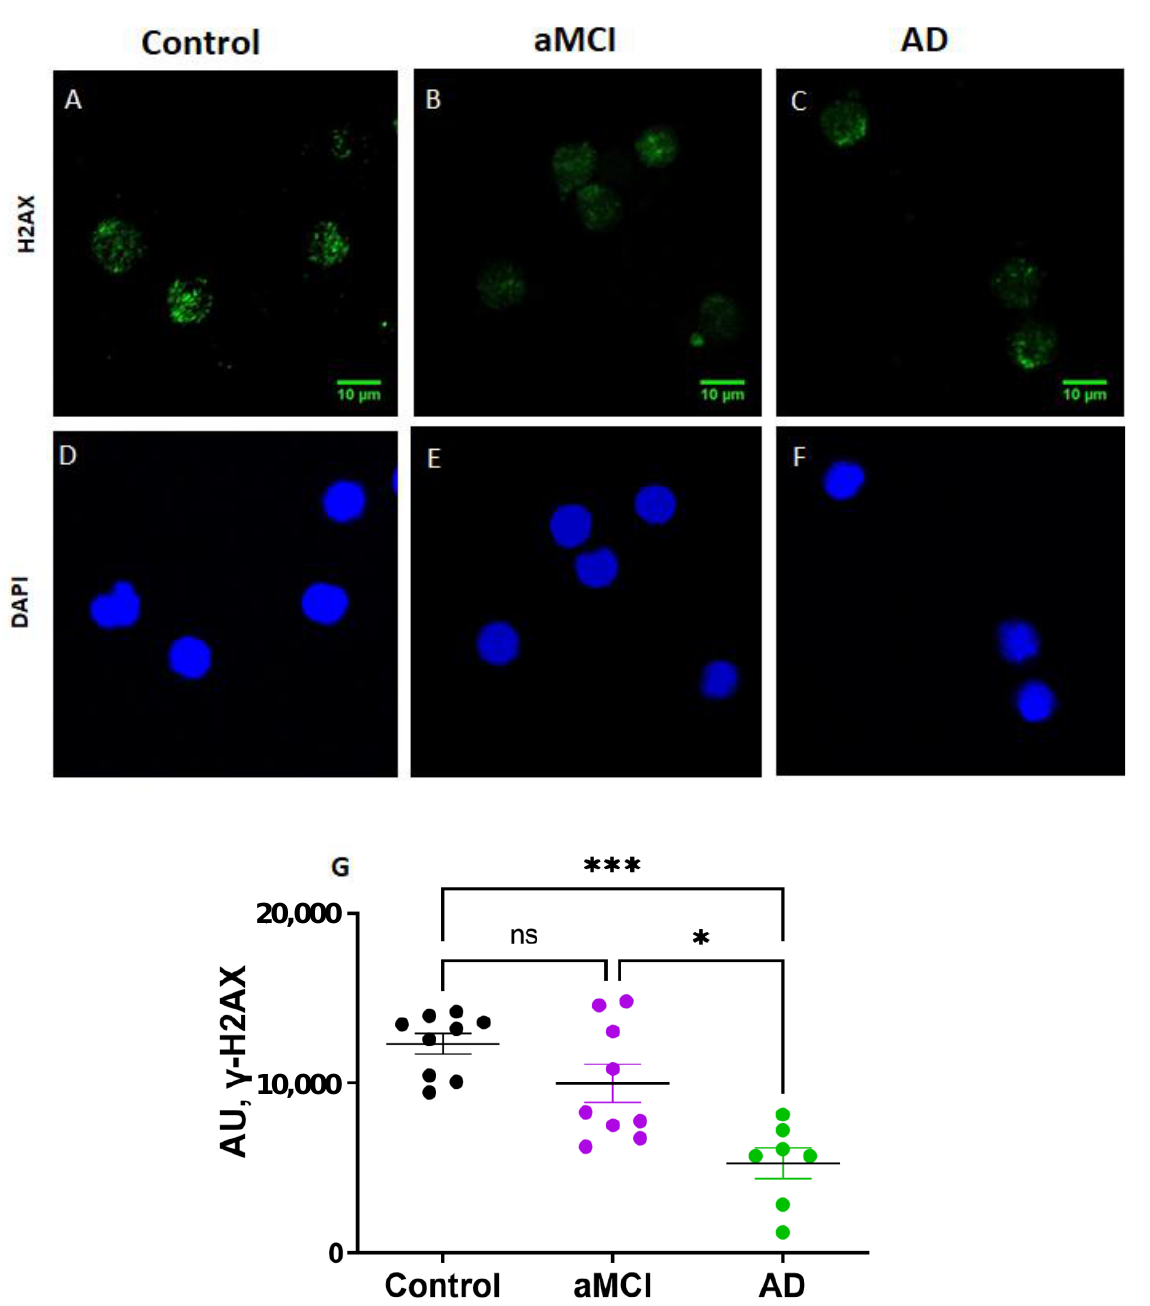
Figure 4. Activation of the DNA damage response determined by γ H2AX activity was decreased in PBMCs of AD patients. ( A – F ): Representative immunofluorescence confocal images of γ H2AX staining (green, ( A – C )) and nuclei stained with DAPI (blue, ( D – F )) of PBMCs of a control ( A , D ), an aMCI ( B , E ) and an AD ( C , F ) patient. Scale bars: 10 µ m. ( G ): Immunofluorescence quantification of γ H2AX expression normalized by the number of nuclei in nine healthy controls, nine aMCI and seven AD patients. AU: arbitrary fluorescence units. Statistical analysis: Kruskal – Wallis with Dunn’s post hoc correction, * p < 0.05, *** p < 0.005, ns = non-significant.